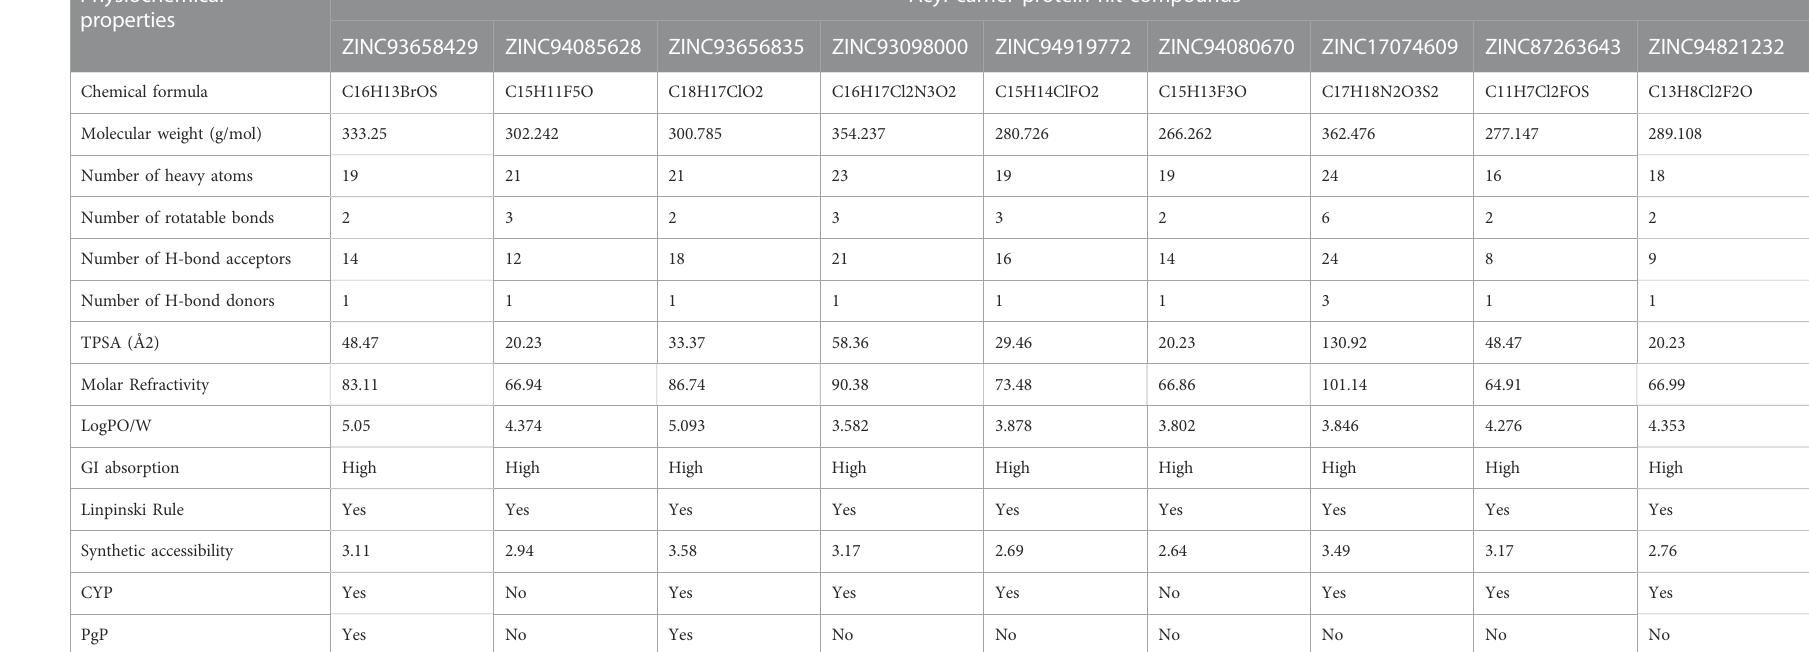
TABLE 3 ADME properties of Acyl Carrier Protein